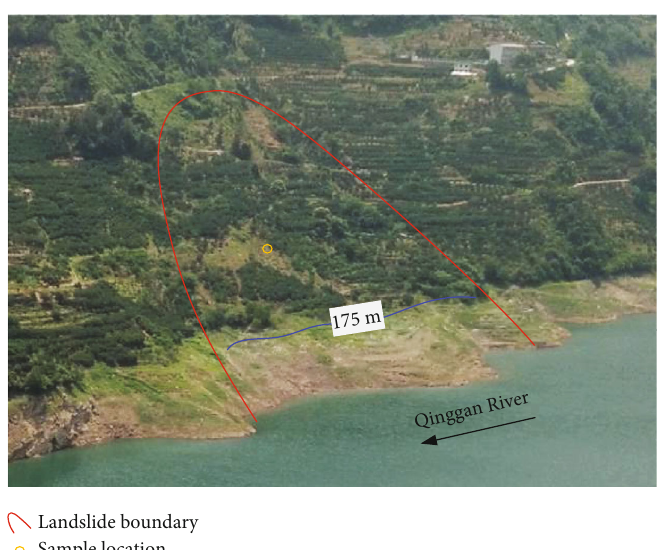
Figure 3: The sampling site of soil samples in the Woshaxi